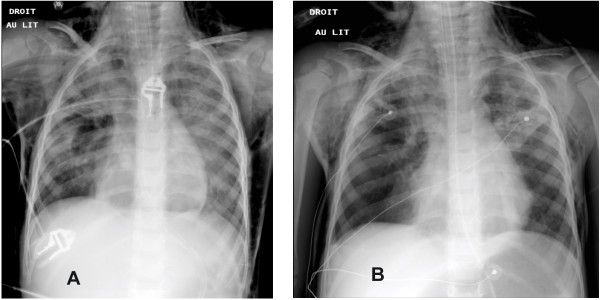
Chest radiographs of case 2. (A) The left X-ray shows bilateral infiltrates associated with diffuse subcutaneous emphysema. (B) Twenty-four hours after the onset of NAVA, the subcutaneous emphysema started to decline. Abbreviations: NAVA, neurally adjusted ventilatory assist.